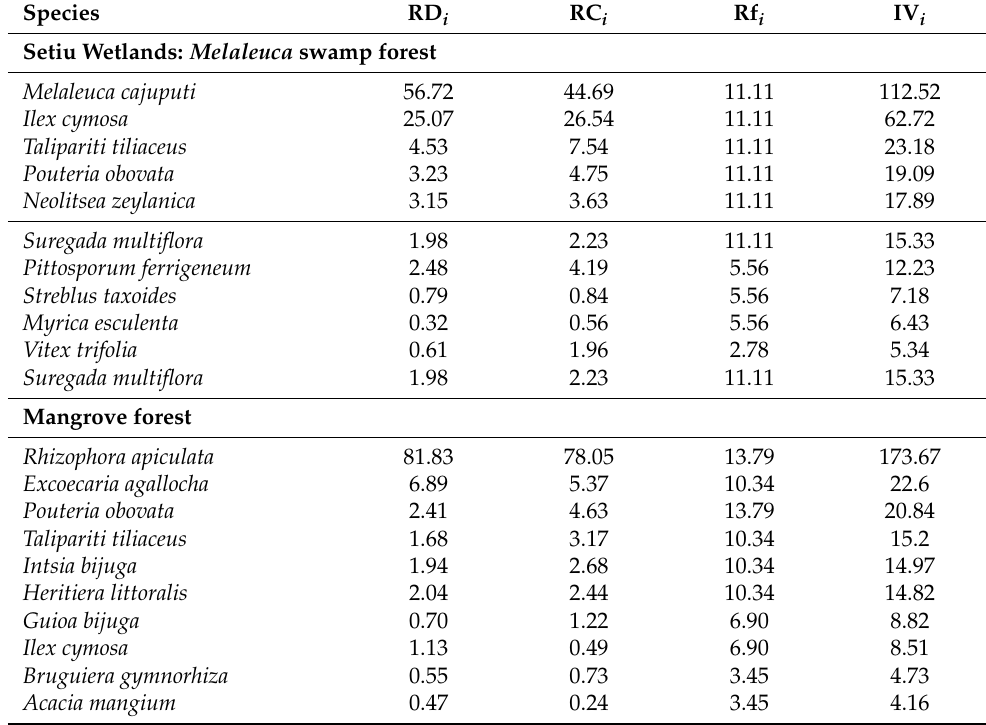
Table 4. Relative dominance (RD i ), relative coverage (RC i ), relative frequency (Rf i ), and importance value (IV i ) of tree species with DBH of 5 cm in Setiu Wetlands and three major islands of Terengganu.